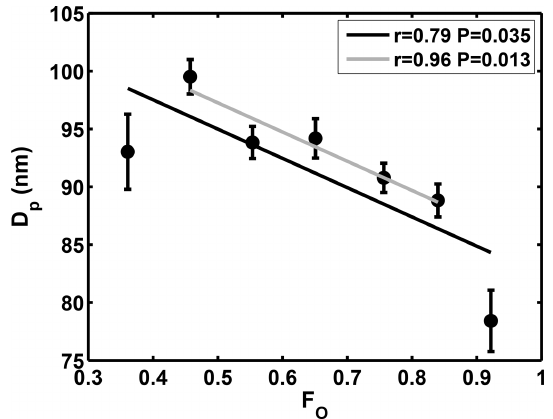
Figure 6. Mean aerosol particle radius ( D p ) as a function of or- ganic mass fraction ( F O ) . The black line is the linear regression line through all F O bins. The gray line is the linear regression line for F O bins ranging from 0.4 to 0.9, which have the most samples. Data are from July and August of 2012. The legend gives the coefficient of correlation ( r ) and the statistical probability ( P